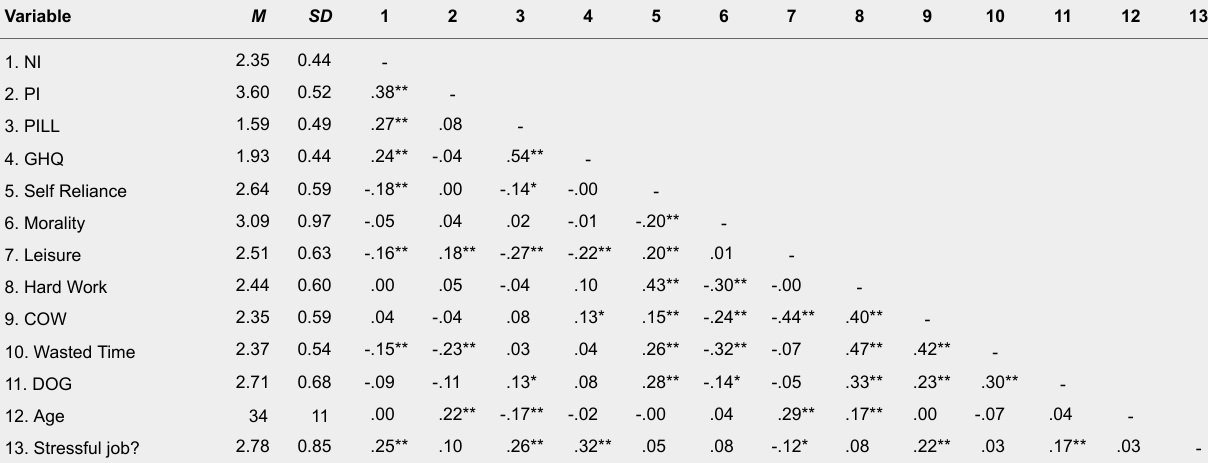
Pearson’s r Correlation Coefficients Between Demographic Variables and Measures of Wellbeing (N = 310) Variable M SD